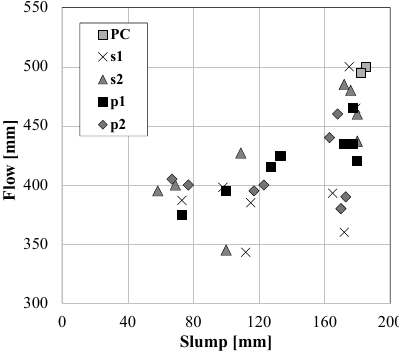
Figure 7. Relationship between flow and slump for PC and FRC.